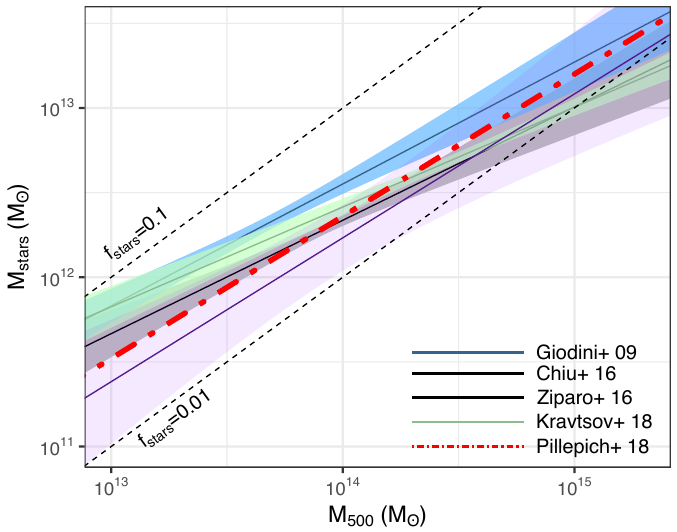
Figure 6. The M stars –M relation of various studies in the literature. Two lines of stellar mass fraction are highlighted by the dashed lines. Please note that the [182] relation is derived from the conversion of L K to M stars assuming a constant mass-to-light ratio of 0.73 (as used in